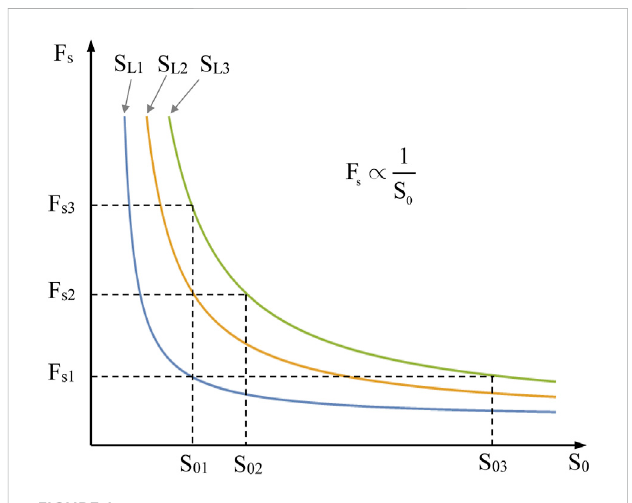
Diagram of the deterioration of clay mechanical